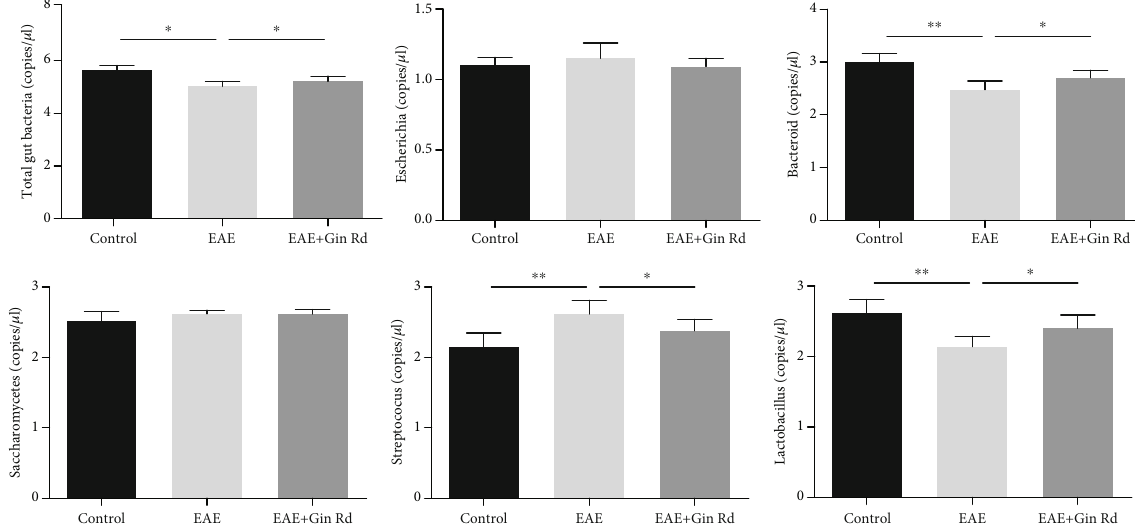
Figure 5: Relative content of gut bacteria in di ff erent groups by qRT-PCR analysis. Data are expressed as the mean ± SEM of each group ( n = 3 ). ∗ P < 0 : 05 , ∗∗ P < 0 : 01 vs. EAE group. Gin Rd: Ginsenoside